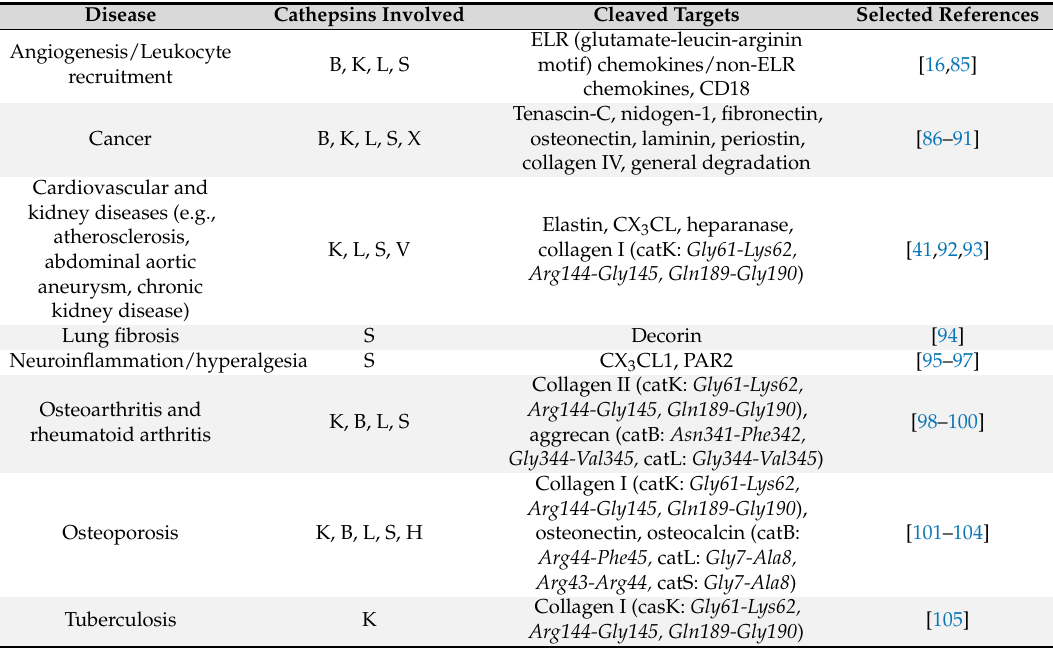
Table 2. Cathepsins in